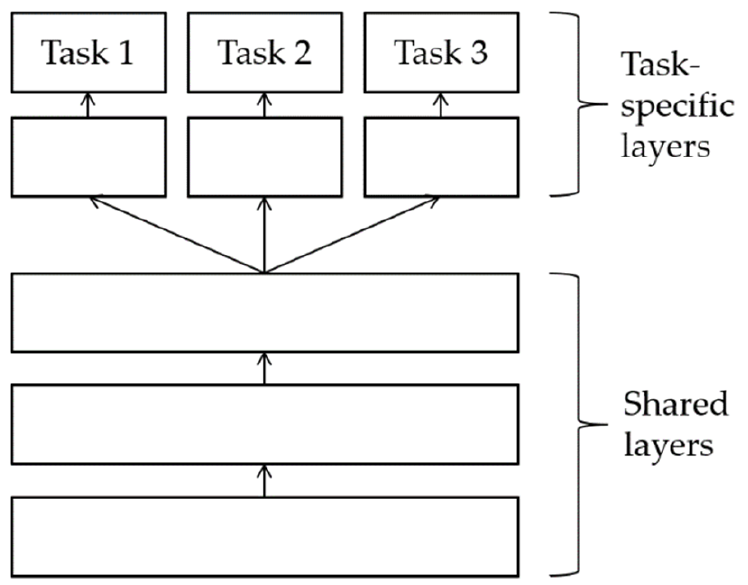
Figure 8. A structure of multi-task learning model using hard parameter sharing method. Multi-task learning can generalize the data by minimizing or ignoring the noise in training multiple tasks. Generalized latent representation thus can be trained for multiple tasks that are simultaneously executed